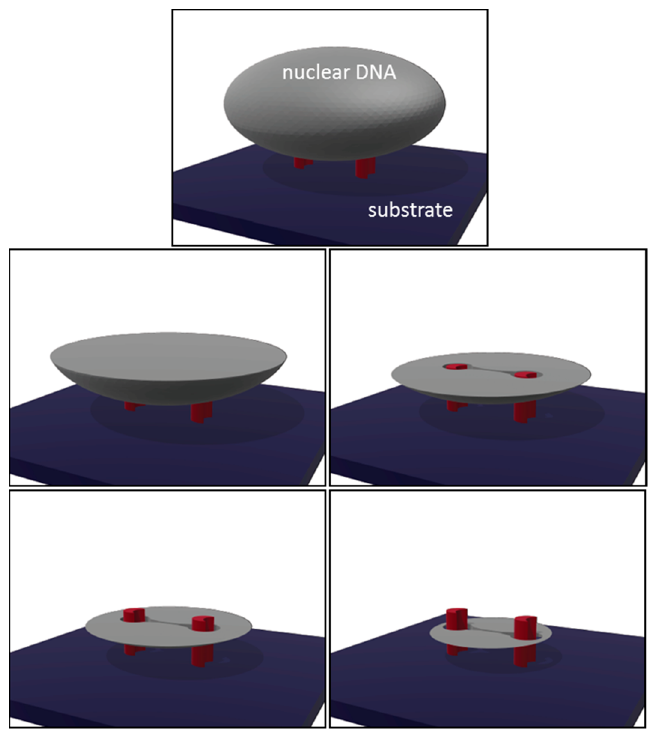
Figure 6. Schematic drawings of nuclear DNA elements (gray) surrounding two C-shaped pillars (red) at different cross-sectional planes above and below the pillars. Note the DNA materials are not in direct contact with the pillars. The tear drop-shaped openings in between the pillars indicate the slit location.